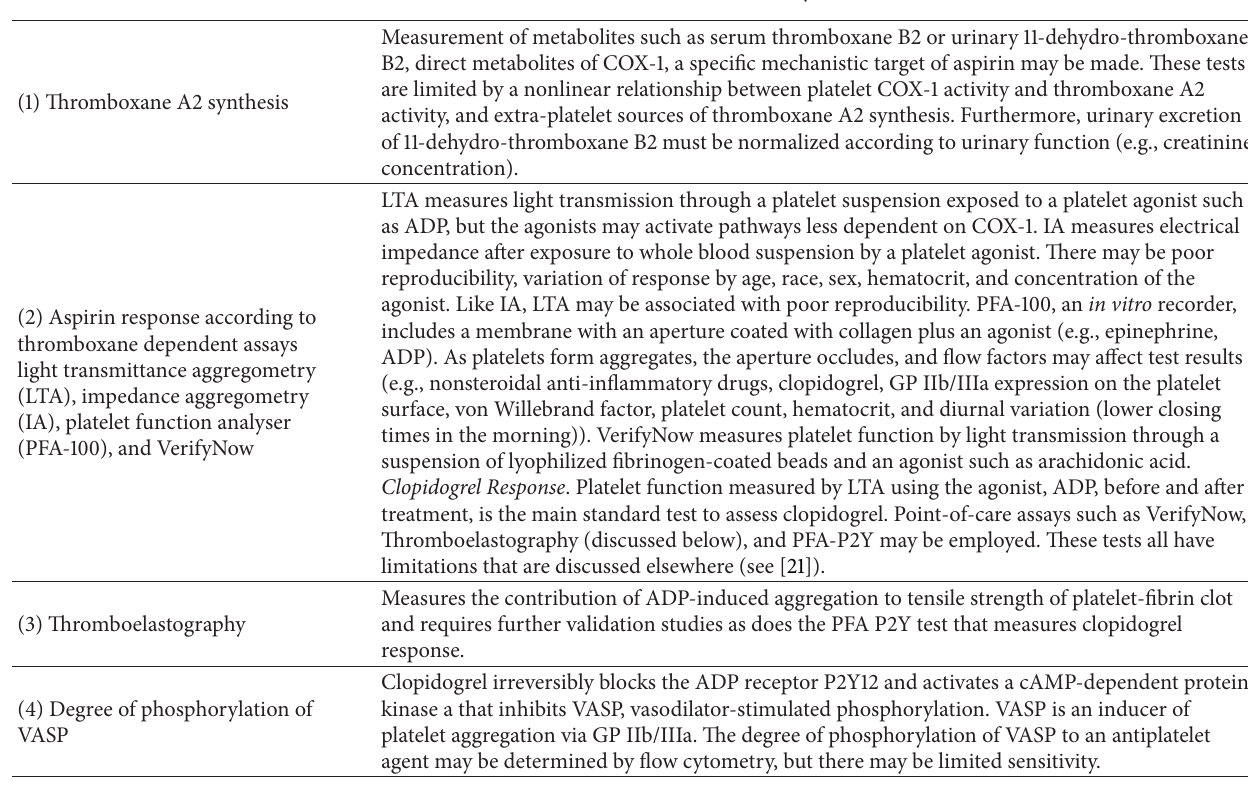
Table 2: Platelet function tests and commentary [18,